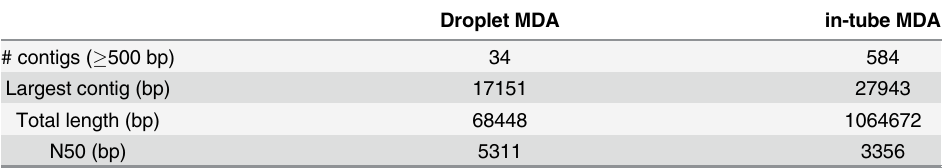
Table 1. Assembly statistics of sequence reads obtained from MDA products of contaminants in no template control (NTC) samples. Droplet MDA in-tube MDA # contigs ( (cid:1) 500 bp) 34 584 Largest contig (bp) 17151 27943 Total length (bp) 68448 1064672 N50 (bp) 5311 3356 A total of 10 μ L of MDA mixture was used in both droplet MDA and in-tube MDA reactions. In both droplet MDA and in-tube MDA, a total of 1 ng of MDA product was used for sequence library preparation. Row sequence reads were obtained at 100× sequencing